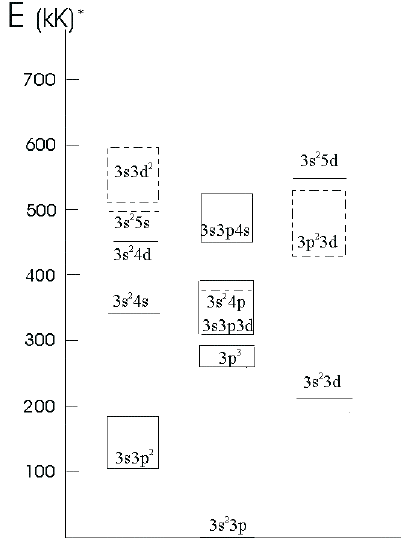
Figure 4. Gross structure of the experimental and theoretical (dotted line) Ar VI configurations. ‘kK’ means 10 3 cm −1 . Reproduced by permission of IOP Publishing from [48] (© The Royal Swedish Academy of Sciences. All rights reserved.)